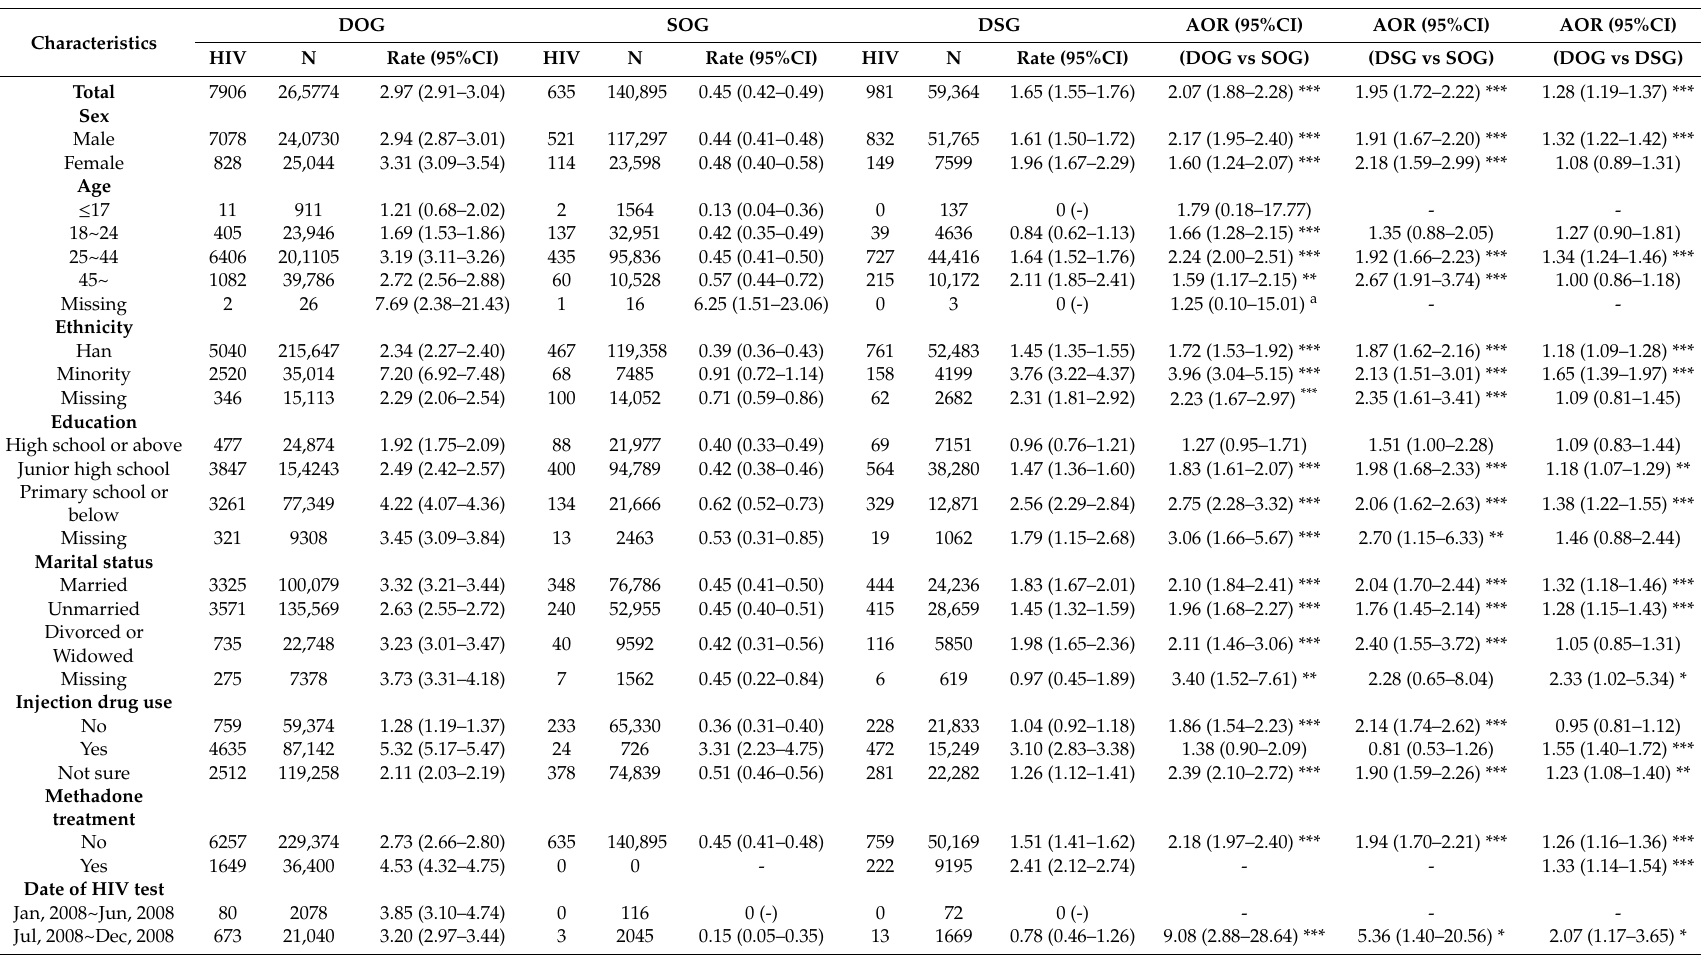
Table 2. Comparison of HIV infection rates by characteristics among opioid-type only, synthetic-type only and both opioid-type and synthetic-type drug users.